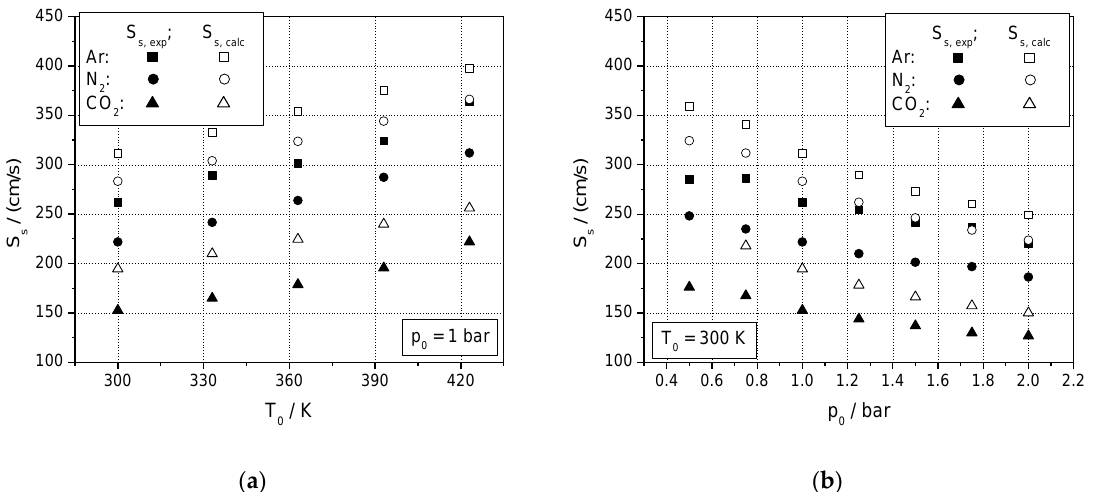
Figure 6. Comparison of experimental and calculated PVs of stoichiometric (C 3 H 8 -air) + diluent: ( a ) at various initial temperatures; ( b ) at various initial pressures.